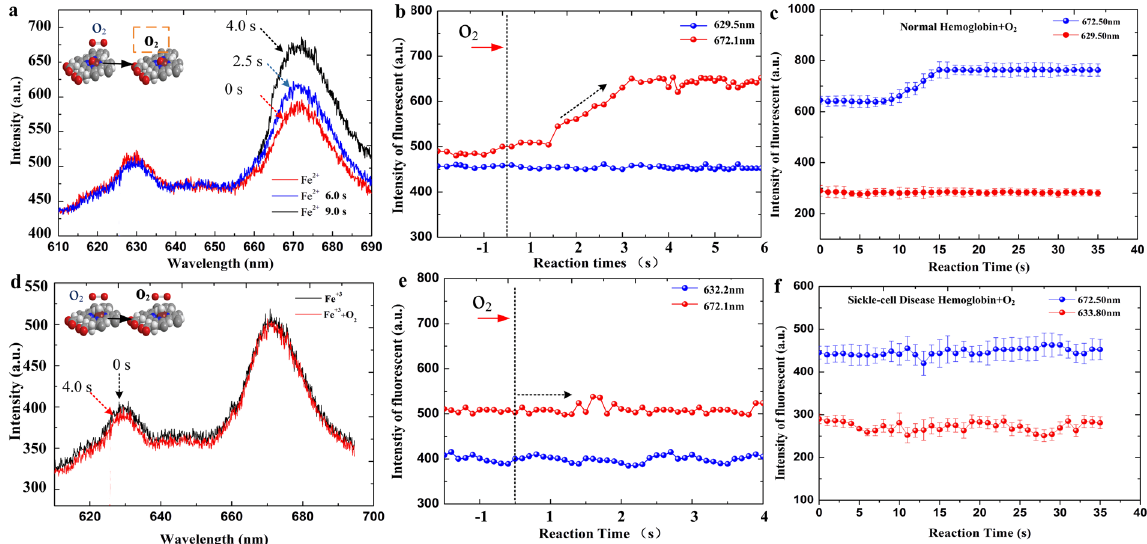
Figure 5. Dynamic oxidation process of the Heme and Metheme, respectively. ( a ) and ( d ) Fluorescent spectra of the Heme and Metheme before and after the oxidation. ( b ) and ( e ) Time dependent variation of the fluorescent peak intensities during the oxidation process. ( c ) and ( f ) Comparison experiments via the Hemoglobin specimen from normal person and SCD patient, which are provided by Ruijin